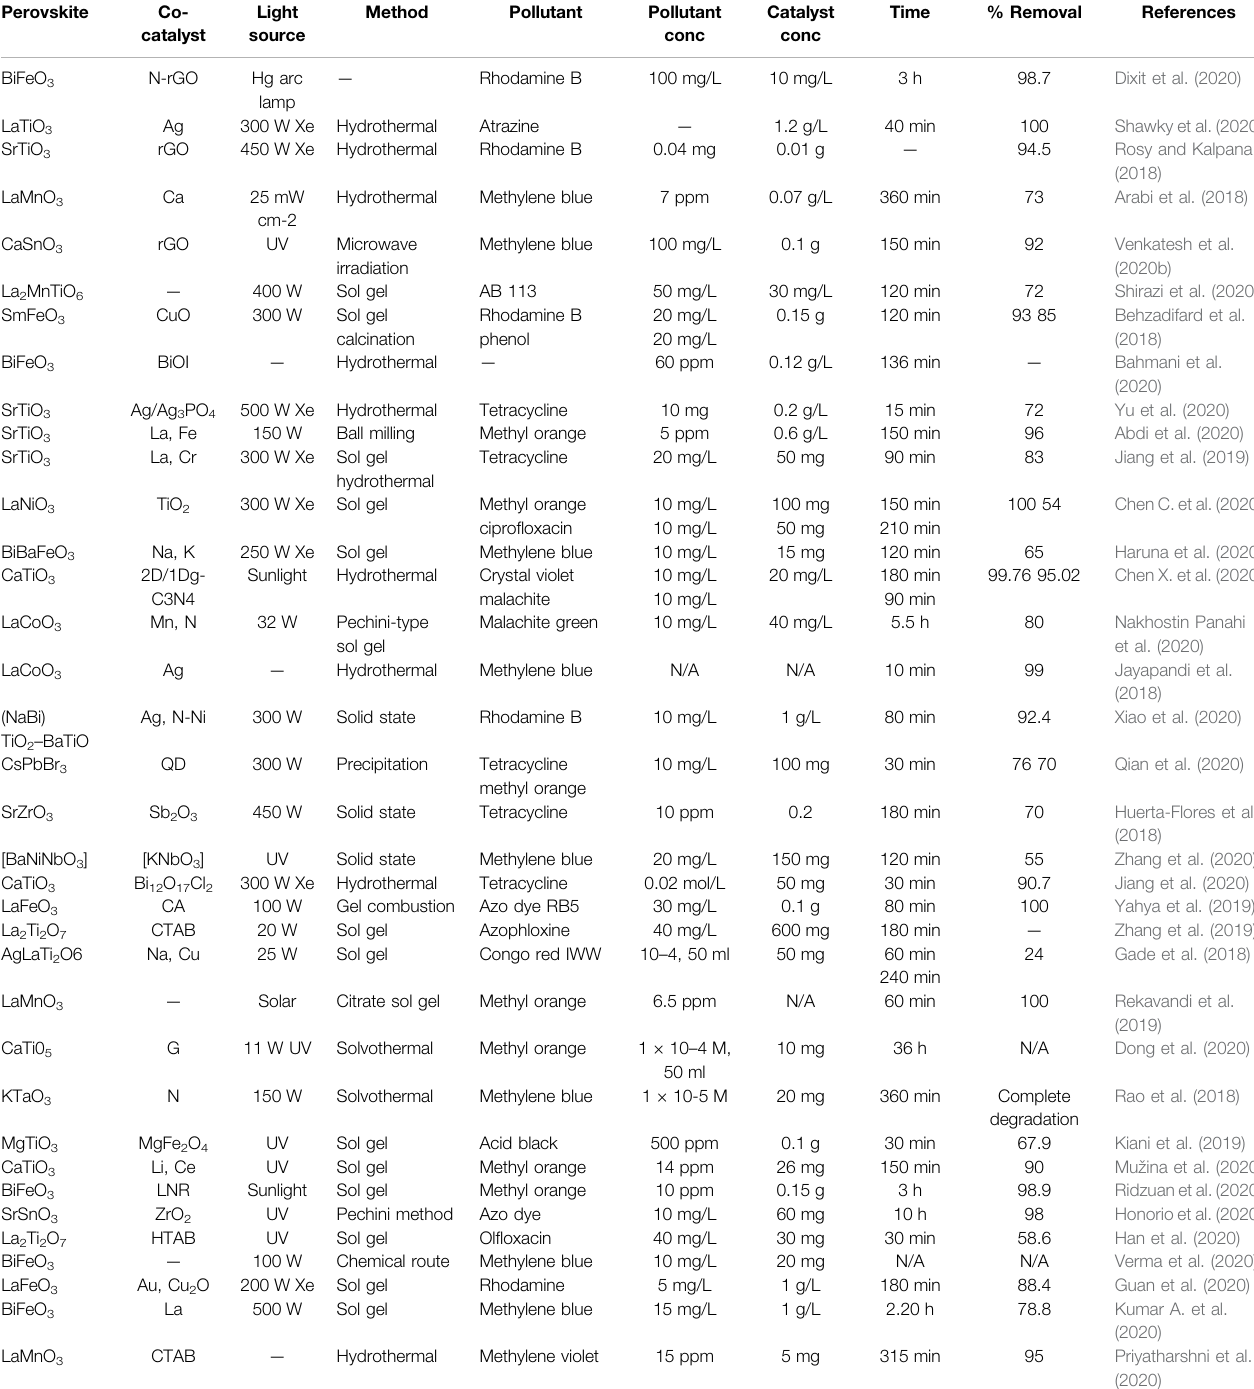
TABLE 1 | Recent perovskites in photocatalysis for water treatment.